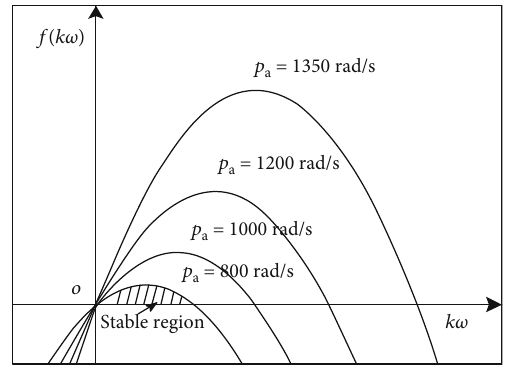
Figure 7: The stable region for di ff erent spinning rate of the aft